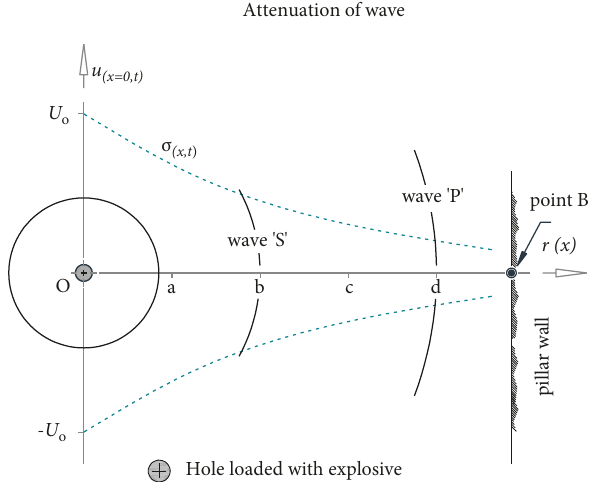
Figure 2: Dynamic stress dissipated in the pillar after the hole detonation started (adapted from [19]).